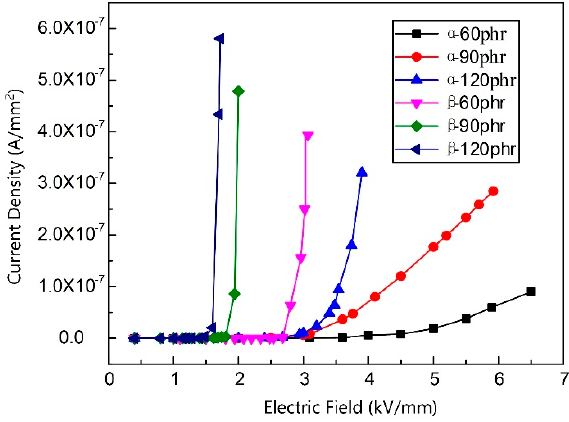
Figure 4. J–E curves of the epoxy/SiC composite samples with different SiC crystal morphologies.